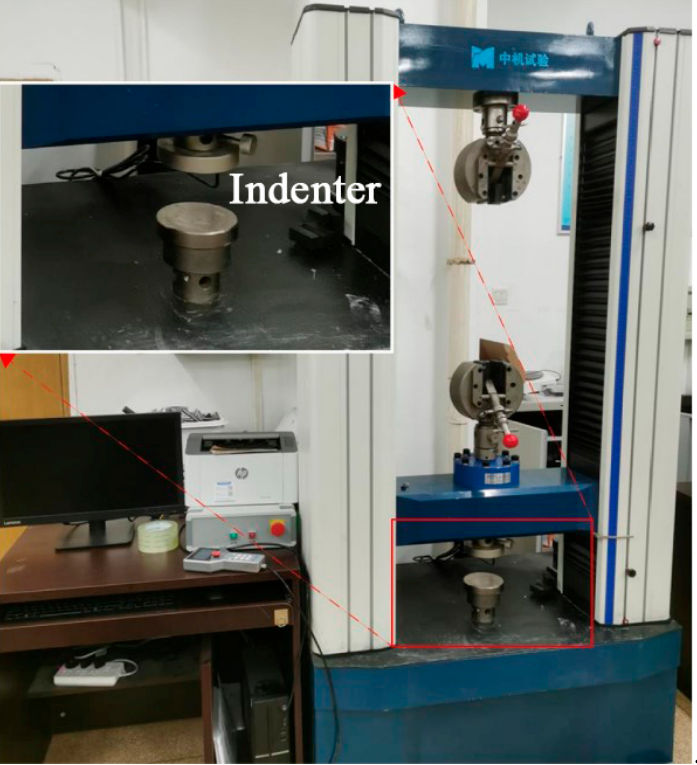
Figure 3. Universal testing machine.